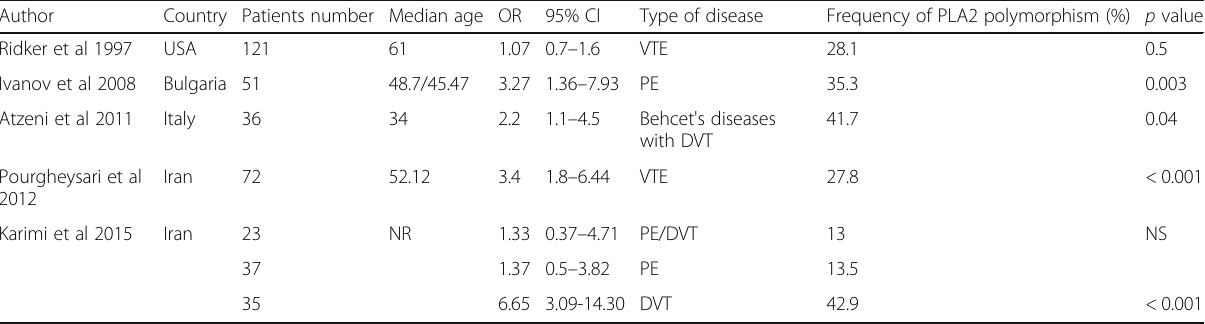
Table 1 Extracted data from included studies investigating the correlation between PLA2 polymorphism and VTE